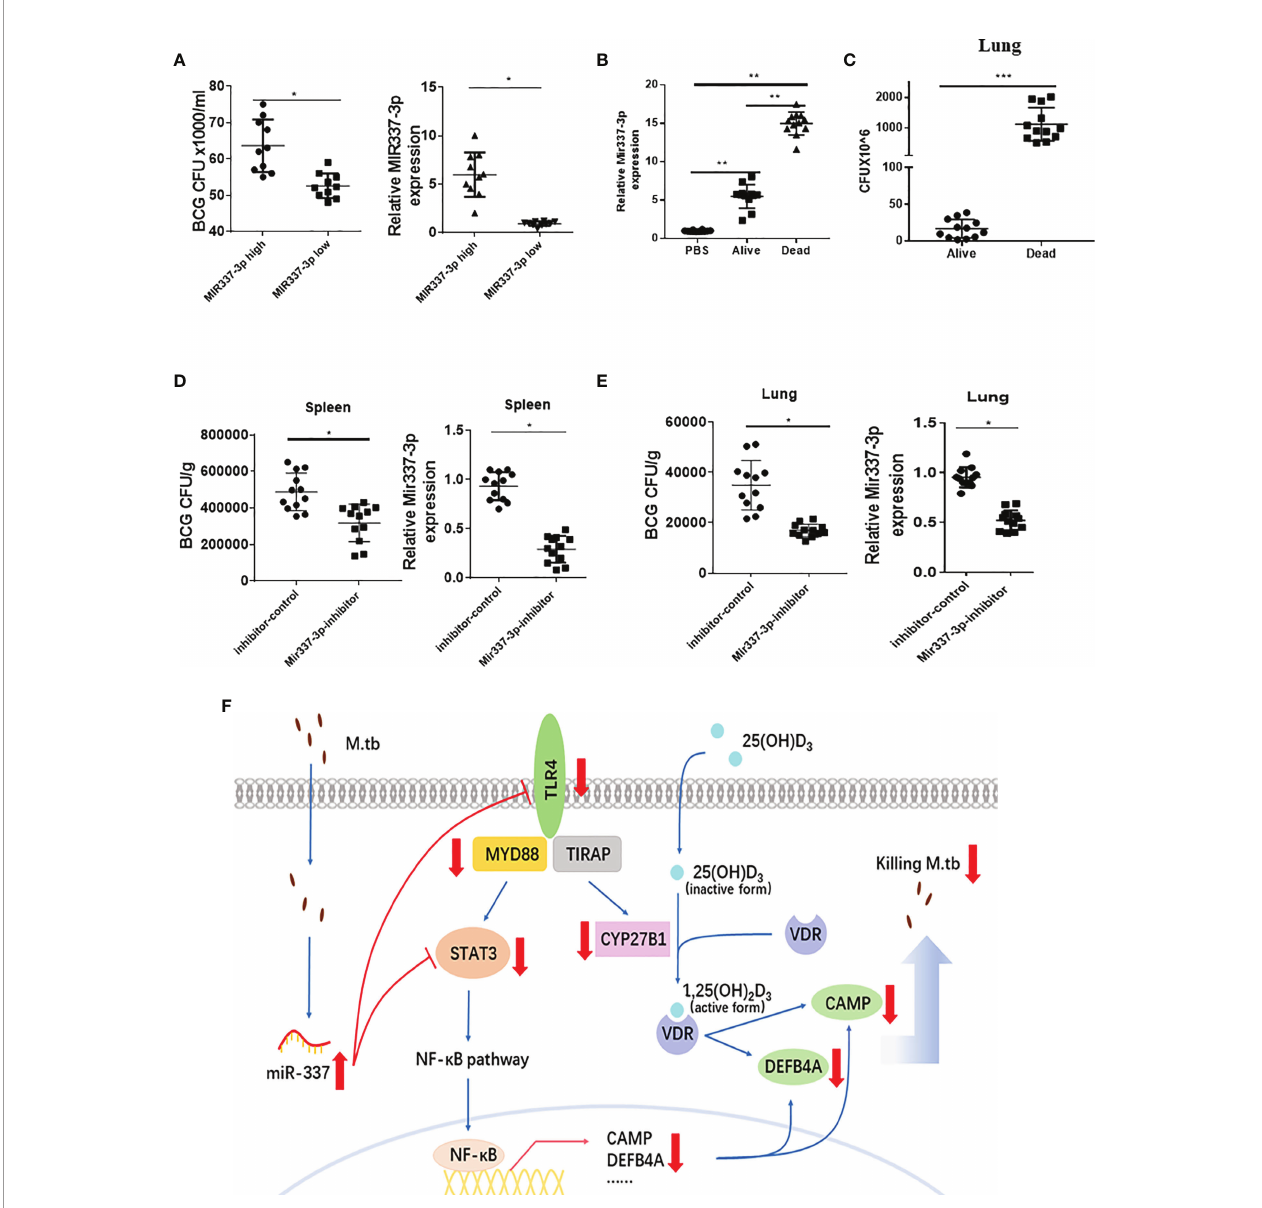
FIGURE 8 | Mycobacterium -driven MIR337-3p/Mir337-3p reduced fast-acting cellular immunity against mycobacterial infection. (A) shows the BCG CFU counts in cocultures of BCG-infected A549 cells and PBMCs isolated from subjects expressing high and low MIR337-3p expression levels (left panel), respectively. Animals were divided into high and low MIR337-3p expression level groups (n = 10) (right panel). (B) shows relative Mir337-3p expression in lungs of PBS- and BCG-infected mice (n = 12). The BCG-infected mice were divided into alive and dead groups at 3 weeks after high dose of BCG (1 × 10 7 CFU) challenge. (C) shows BCG CFU counts in lungs of alive and dead mice, respectively, at 3 weeks after BCG challenge. (D) shows BCG CFU counts (left panel) and Mir337-3p expression levels (right panel) in spleen of mice (n = 12) treated with Mir337-3p inhibitors (lentivirus construct) or controls at 3 weeks after BCG infection. (E) shows BCG CFU counts (left panel) and Mir337-3p expression levels (right panel) in lungs of mice (n = 12) treated with Mir337-3p inhibitors or controls. (F) A schematic model postulates that mycobacterial infection upregulates MIR337-3p expression and that MIR337-3p depresses TLR4 and STAT3 expression by binding their 3 ′ -UTRs and inhibits the downstream CAMP, DEFB4A expressions, leading to impairing of VDR-mediated antimicrobial responses. *P < 0.05, **P < 0.01, and ***P <